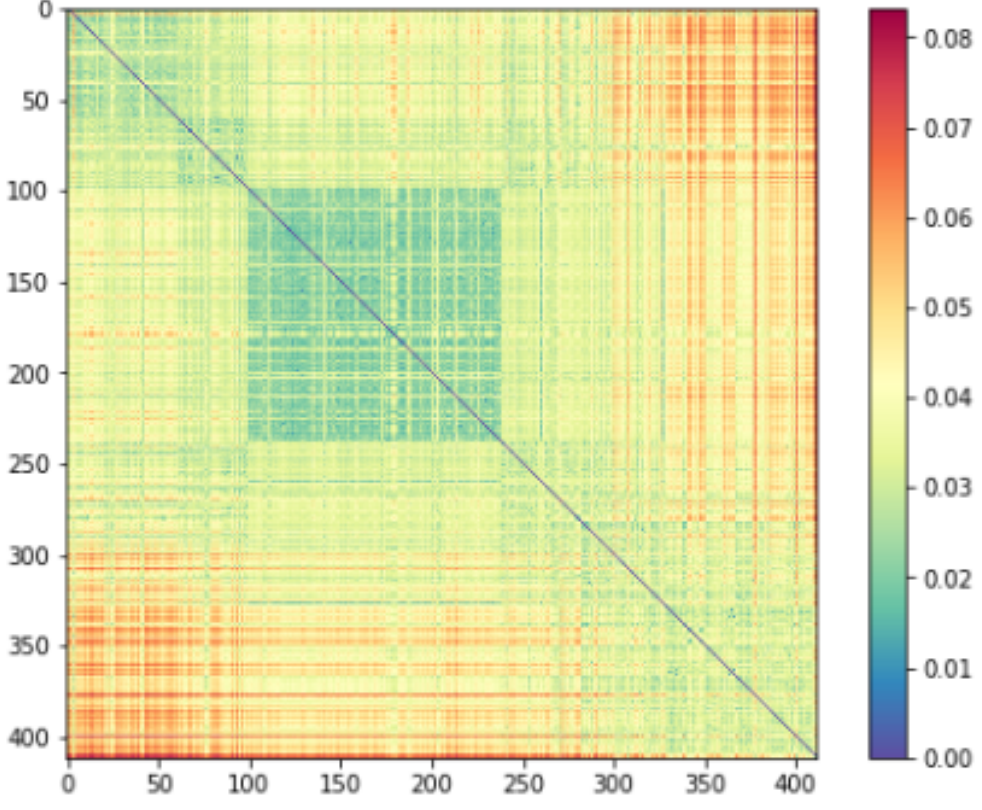
Figure 7. The final best-fitting re-weighted and linearly re-combined explanatory model found using NNLS and representations from BioBERT, achieving a correlation of 0.54 with the ground-truth model. The dimensions of the dissimilarity matrix are sorted by each sentence-pair’s ground-truth semantic similarity